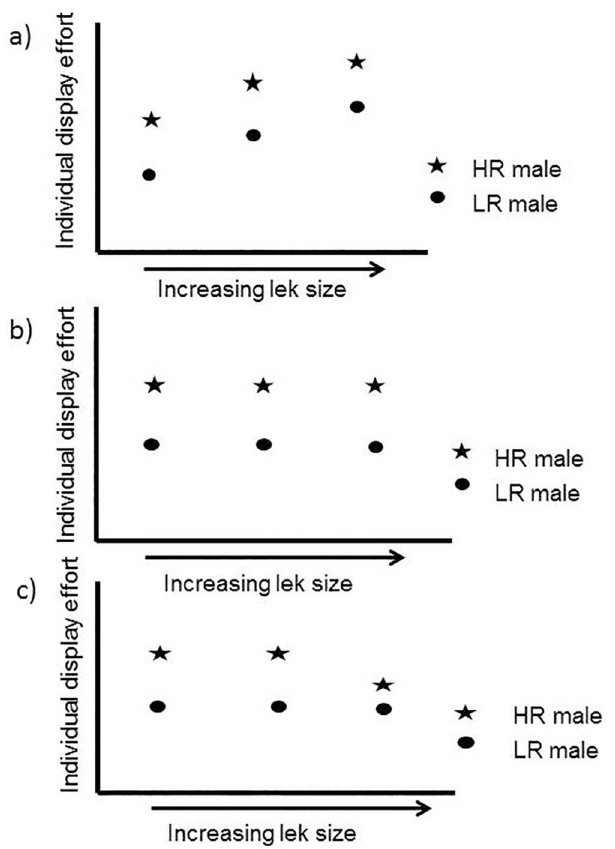
Fig 3. Threehypothetical relationships depictingindividualdisplay effortfor highranking(HR)and low ranking(LR)males on leks of differentsizes. Overall display efforton leks (a) increases,(b) is proportional (equal)or (c) decreases with lek size. These threeexamples are not meantto reflectall